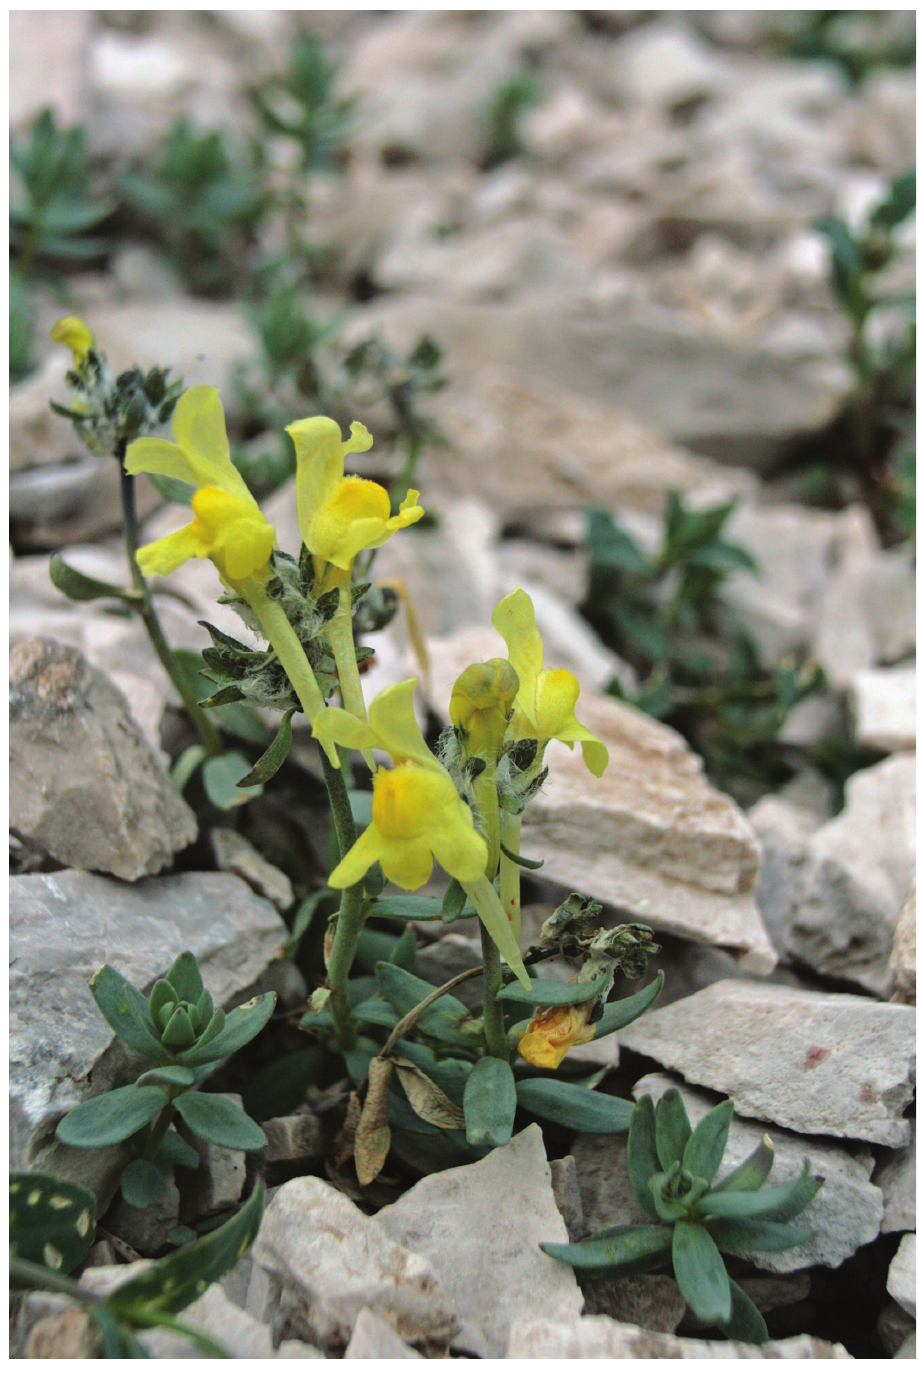
Figure 1. Linaria tonzigii Lona in its locus classicus on Pizzo Arera (2000 m a.s.l., Bergamo, Italy). Pho- tograph by S.